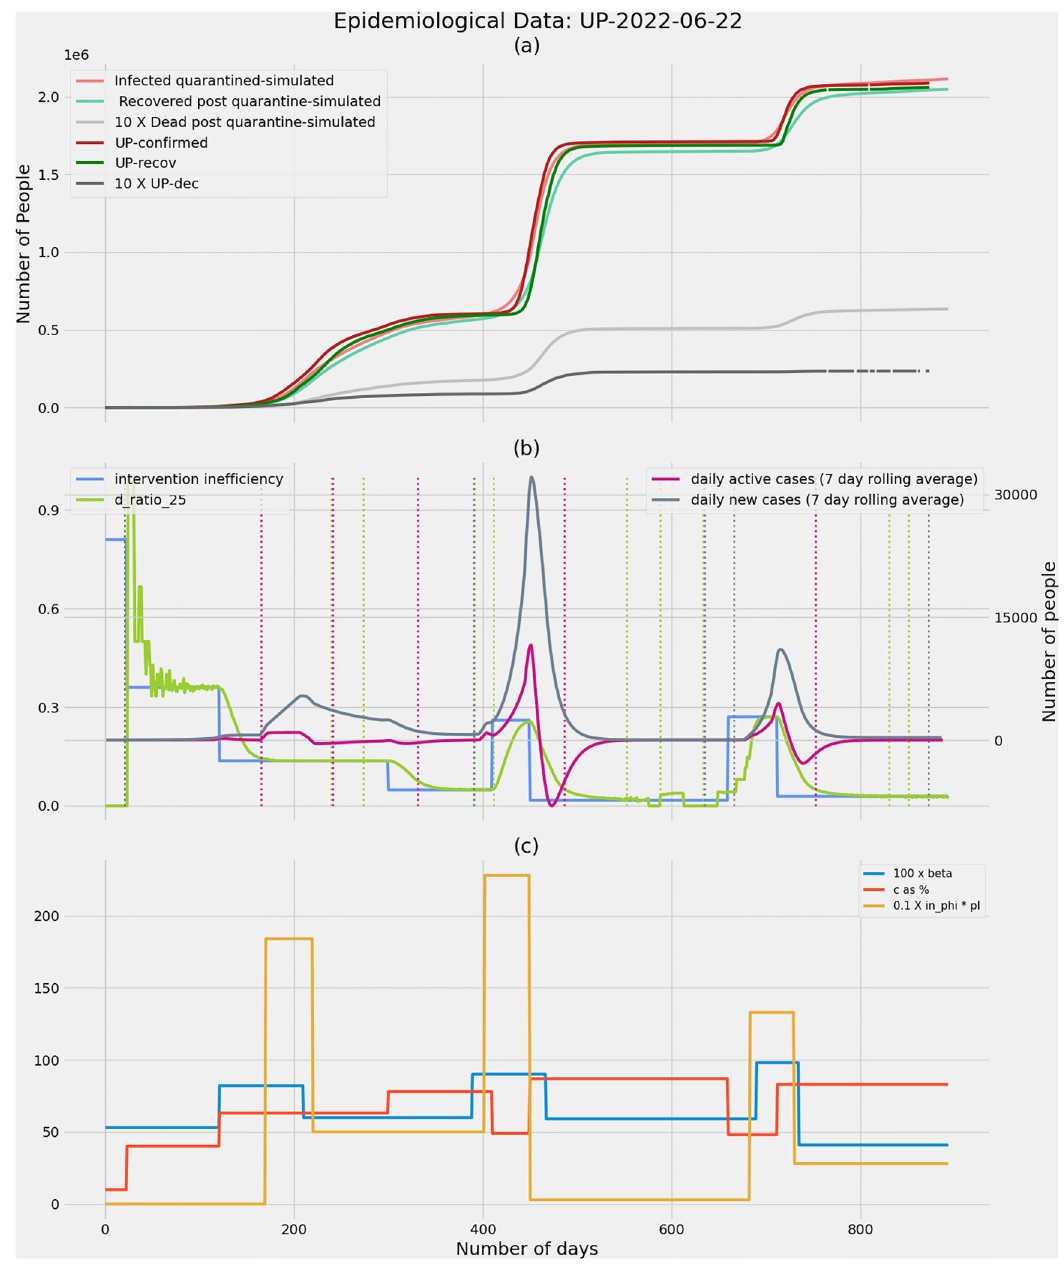
Fig 8. Uttar Pradesh as on 22nd June 2022. (a) Real COVID-19 data and simulated data showing confirmed cases, recoveries and deaths. It is observed that simulations match the real case growth to a great extent. (b) The intervention inefficiency underlying the epidemic is plotted along with the ratio of deaths from undetected infections to total number of deaths (D ratio ), daily new cases and active cases. The dashed vertical lines correspond to the potential time points when an intervention can be made based on the respectively coloured D ratio , daily active cases and daily new cases. D ratio predicts an upcoming wave ahead of other metrics when the wave is precipitated due to a drop in efficiency (decreasing values of ‘c’—the fraction of infections detected through contact tracing). (c) The model parameters beta, fraction of infections that get detected through contact tracing—‘c’, the fraction of infections spread through migrant population—’in phi � pI’ are tuned to fit the model to real